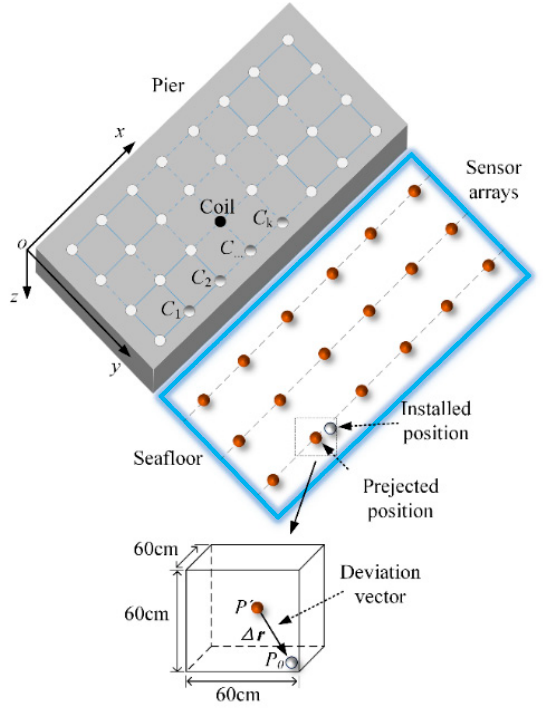
Figure 2. The localization approach for localization by MFG.